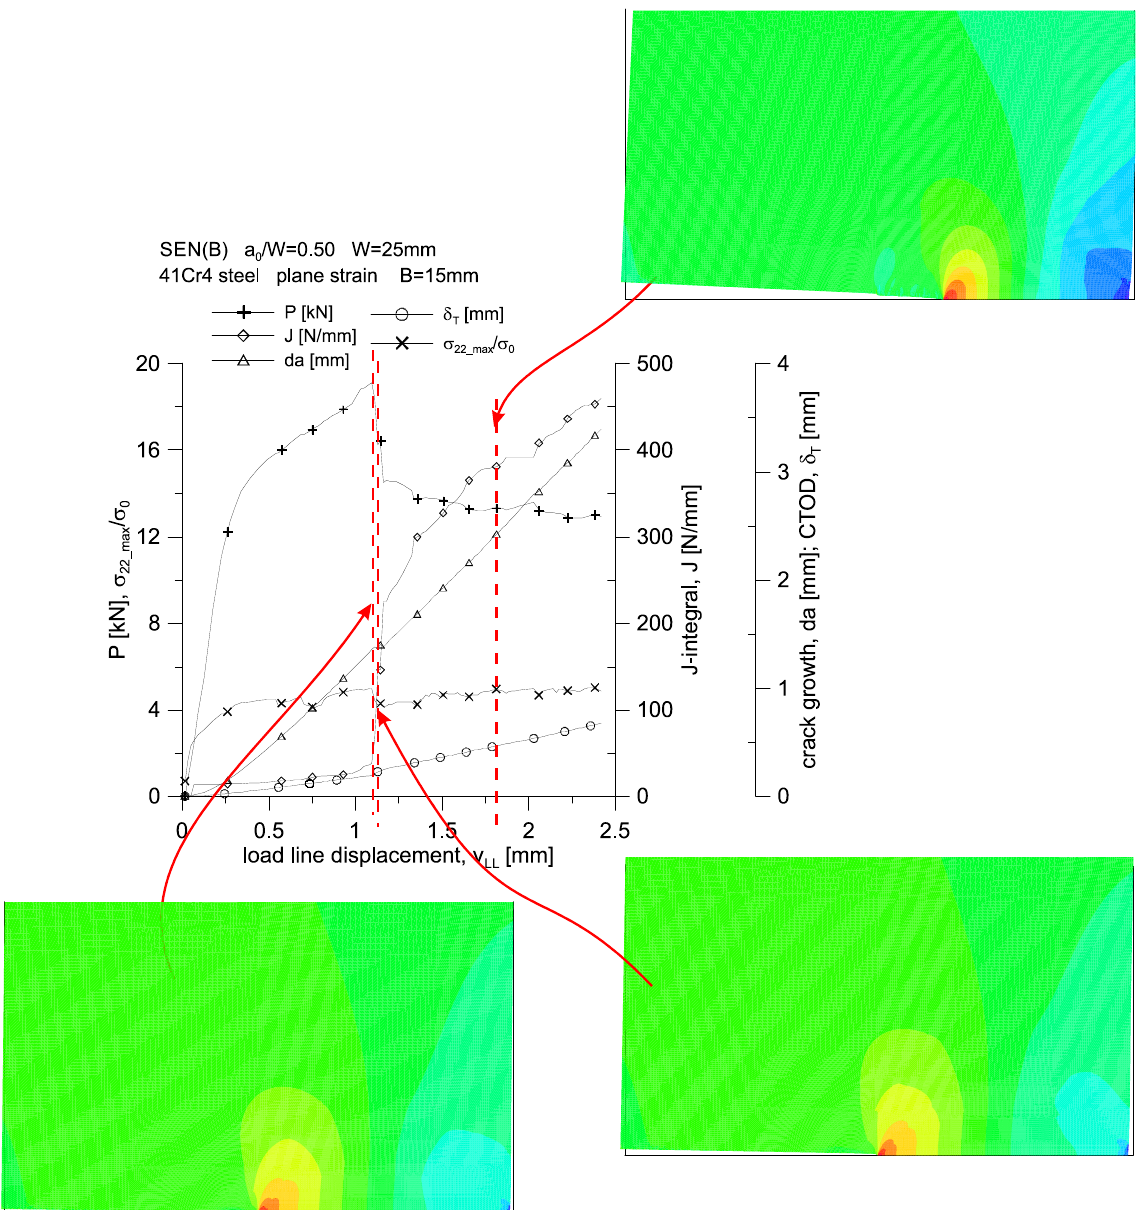
Figure 21. Changes of: the force, P, loading the specimen, the value of the J ‐ integral, the crack length increment, da , the crack tip opening displacement, δ T , and the maximum stresses opening the crack surfaces, σ 22_max / σ 0 , as a function of the load line displacement, v LL , together with the distribution of crack opening stresses, in close proximity to the crack tip. 41Cr4 steel specimen with a thickness of B = 15 mm.